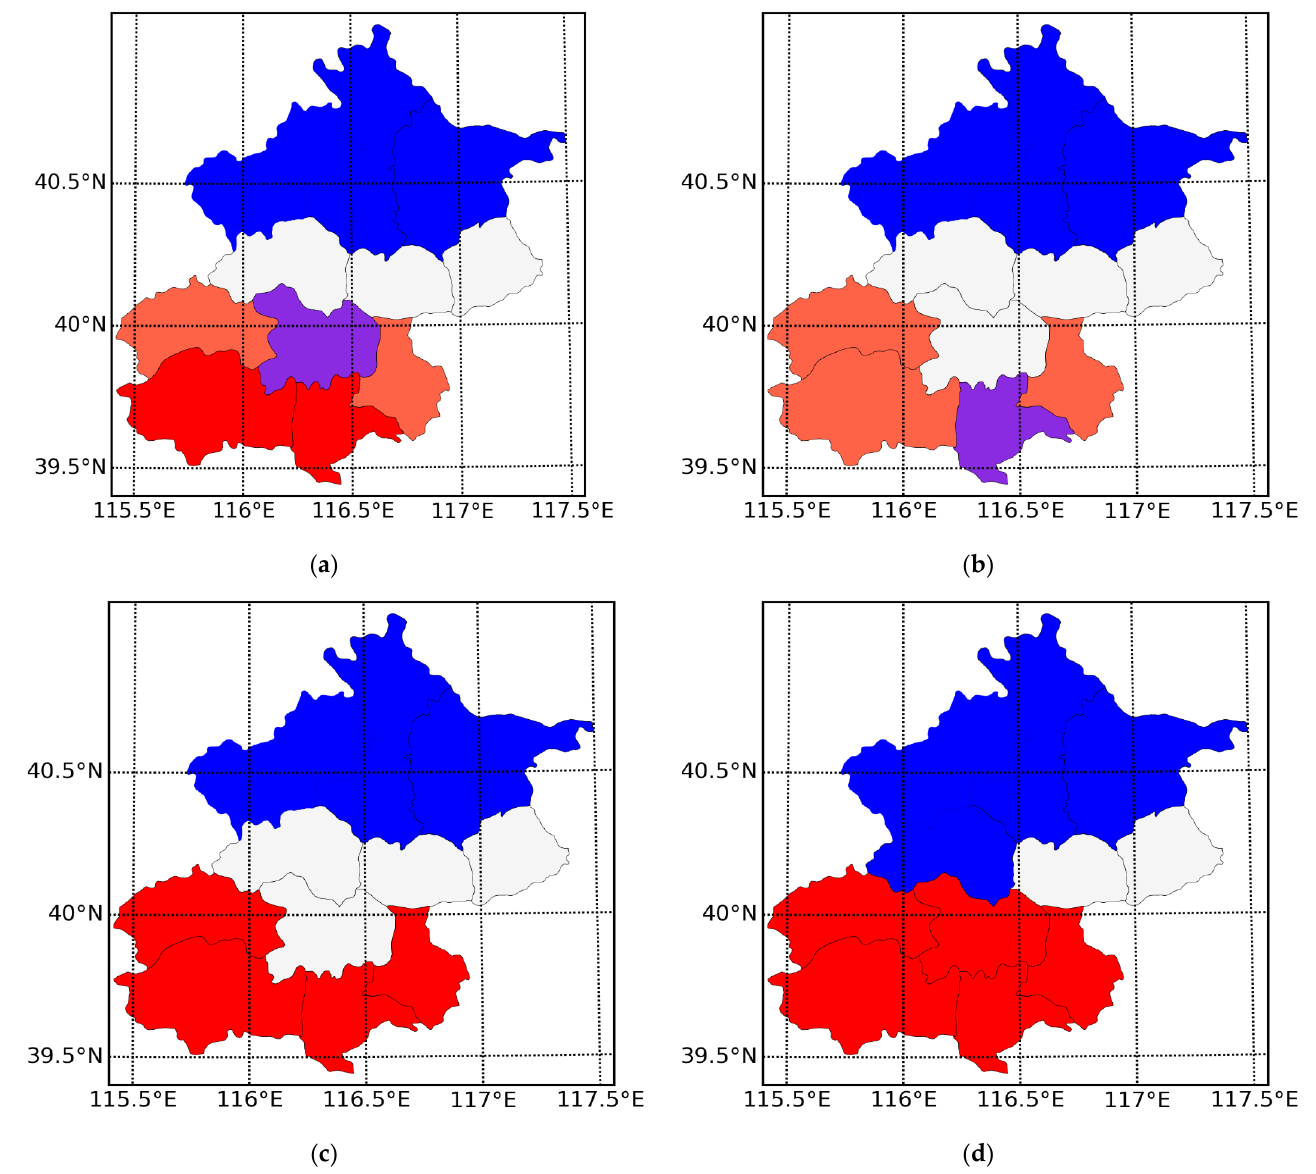
Figure 7. LISA map of the nine regions in ( a ) winter . (b ) spring. ( c ) summer. ( d ) autumn.